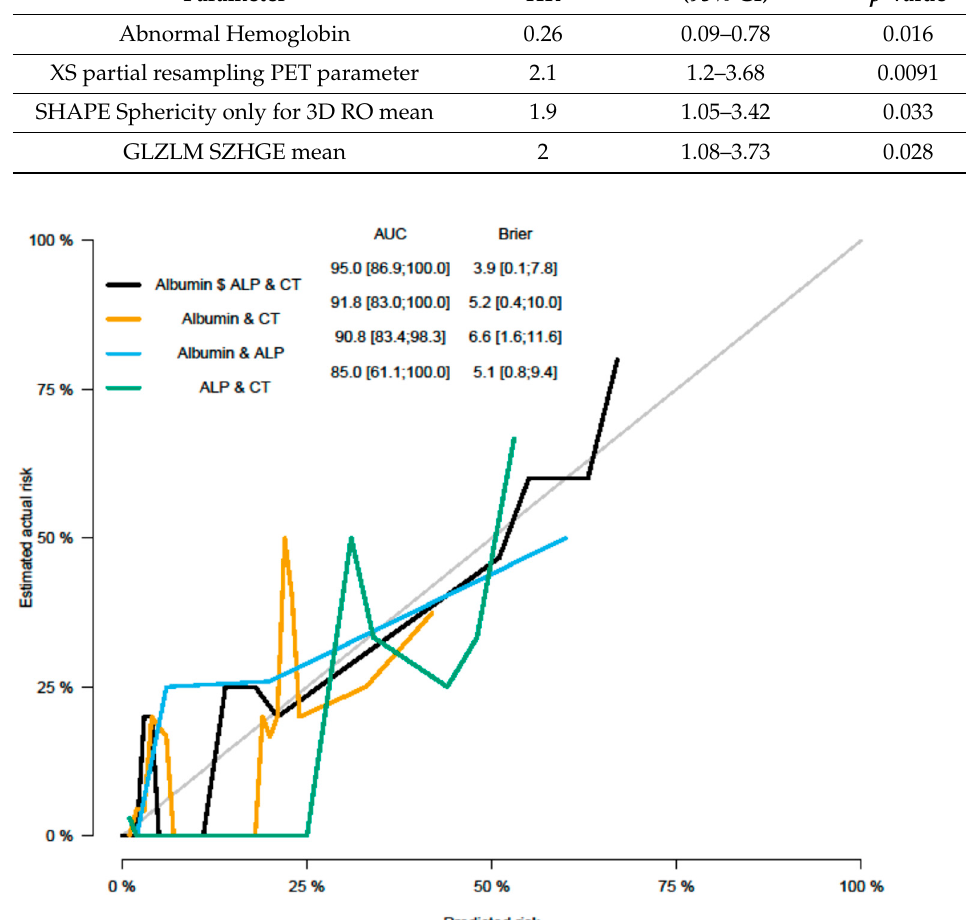
Figure 3. AUC for the fi nal Radiotherapy model provided below.